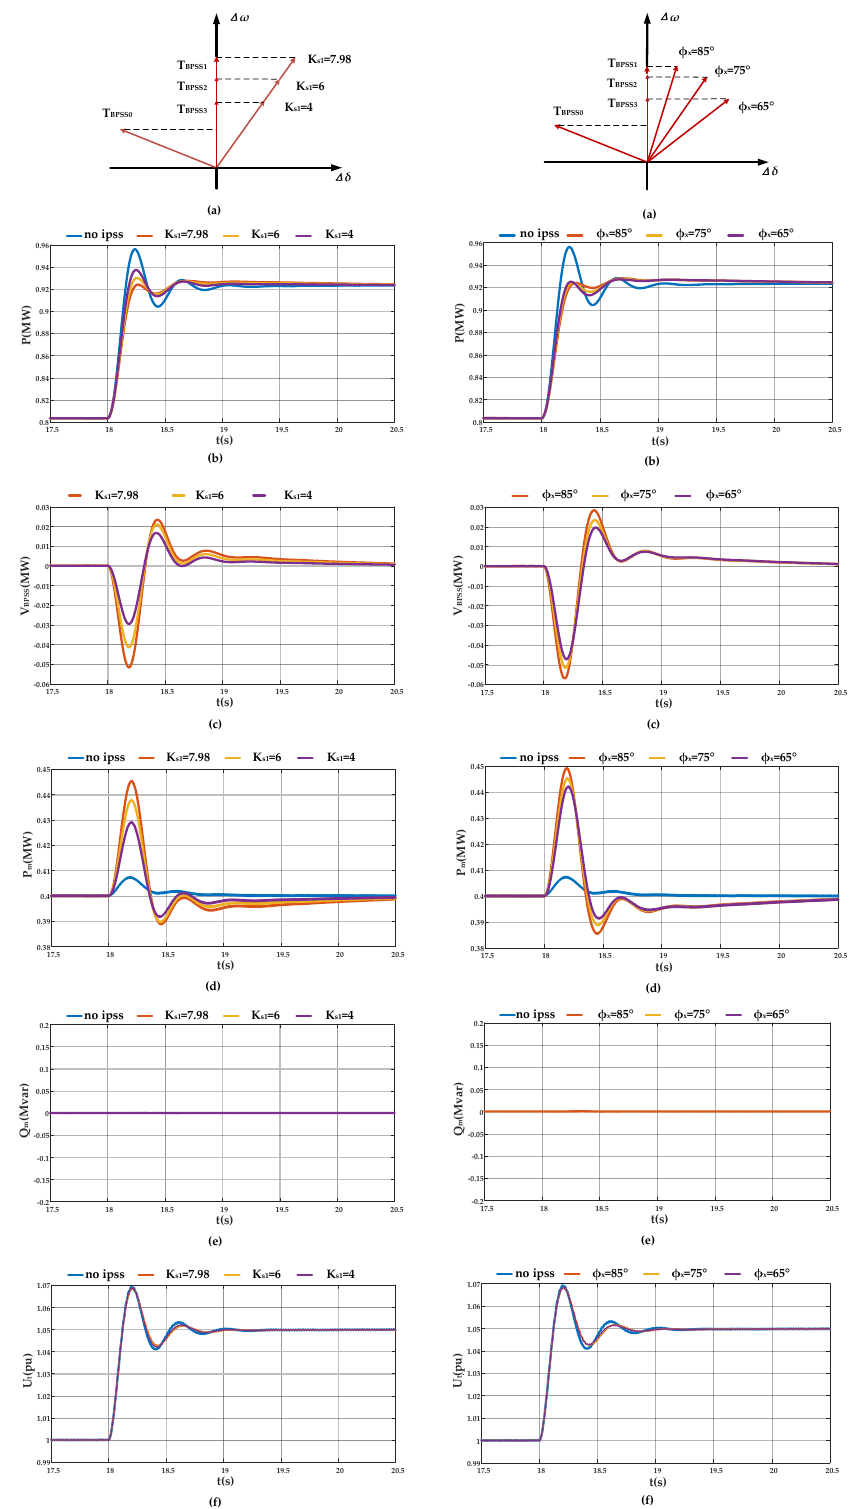
Figure 10. Simulation results of same ϕ x with different AP (case I), same AP with different ϕ x (case II). ( a ) Schematic diagram of damping torque with different AP and ϕ x ; ( b ) active power of generator; ( c ) output of built-in PSS with various ϕ x and AP ; ( d ) active power of grid-connected inverter; ( e ) reactive power of grid-connected inverter; ( f ) terminal voltage of generator.